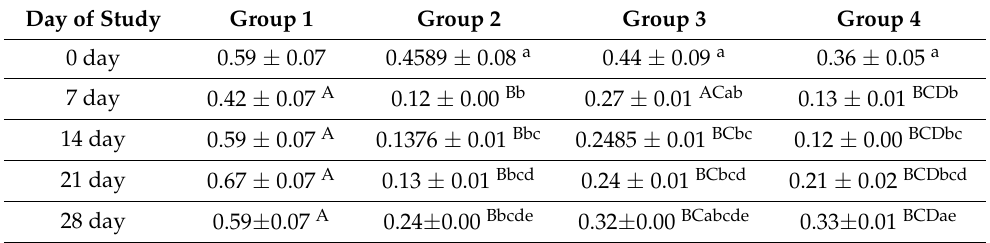
Table 2. Effect of adjuvanted, sonicated antigens on TAS ( µ mol trolox equivalent/L) in rabbits.